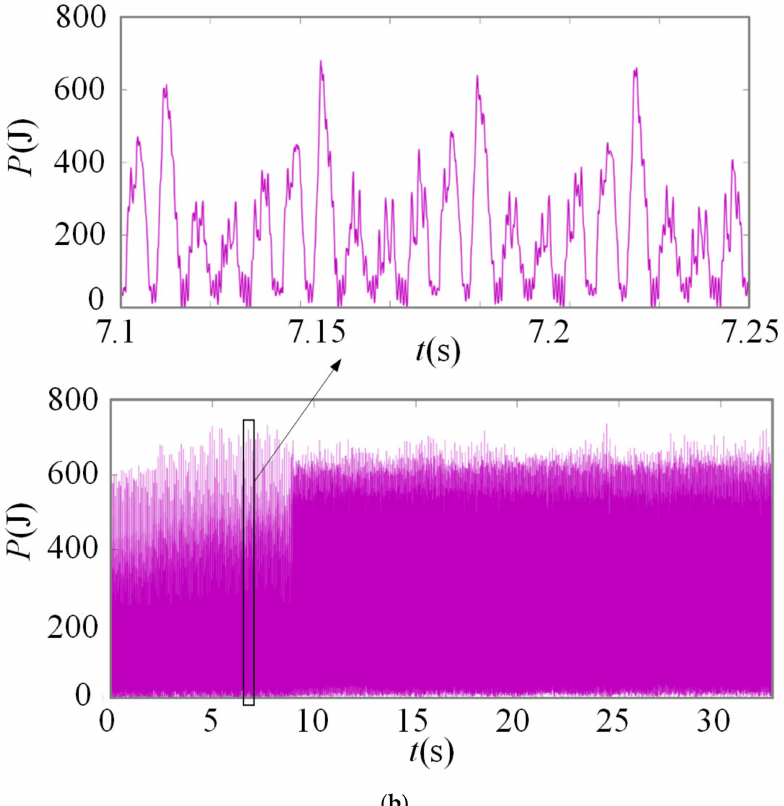
Figure 14. Experimental results of main cutting force energy consumption of milling cutter with time, ( a ) experimental result of energy consumption of scheme 1, ( b )experimental result of energy consumption of scheme 2.